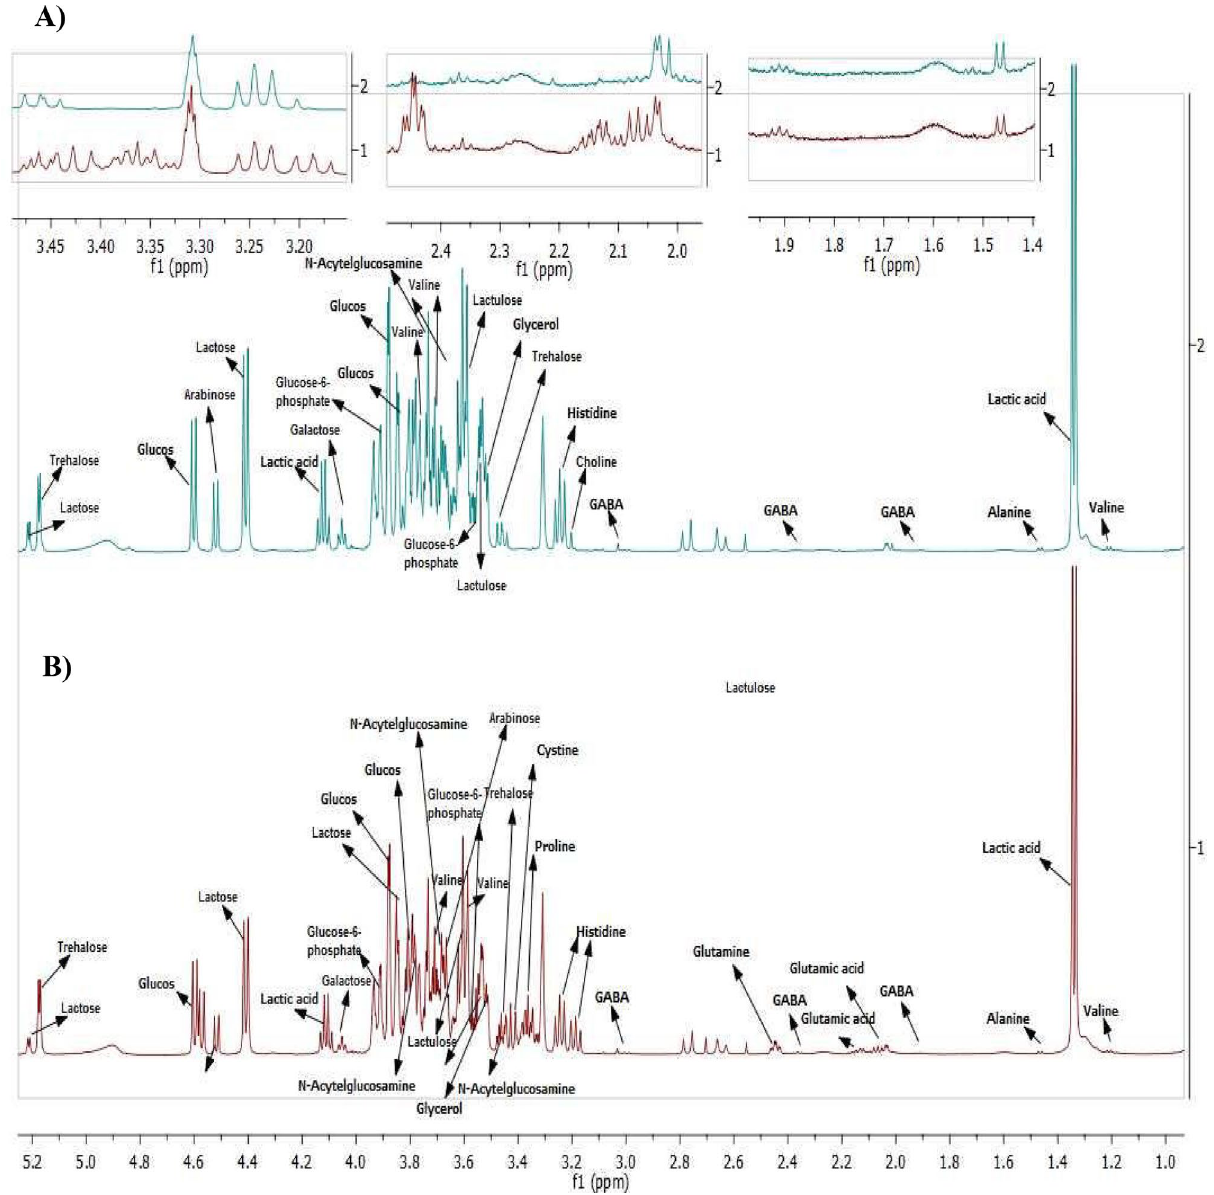
Figure 5. 1 H-NMR spectra of ( A ) freeze-dried standard yoghurt (SY) and ( B ) freeze-dried GABA-rich yoghurt (GY). The spectra was analysed using MestReNova software (Mestrelab, Santiago de Compostela, Spain). https:// mestr elab.